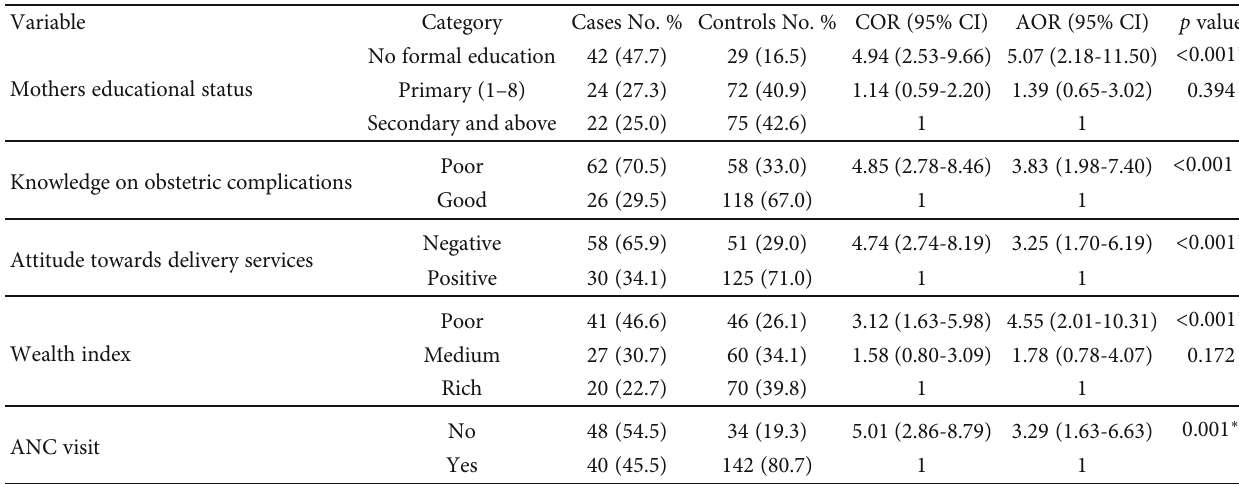
Table 5: Multivariable analysis for determinant factors of home delivery among mothers in Abobo District, Gambella region, Southwest Ethiopia, 2019.